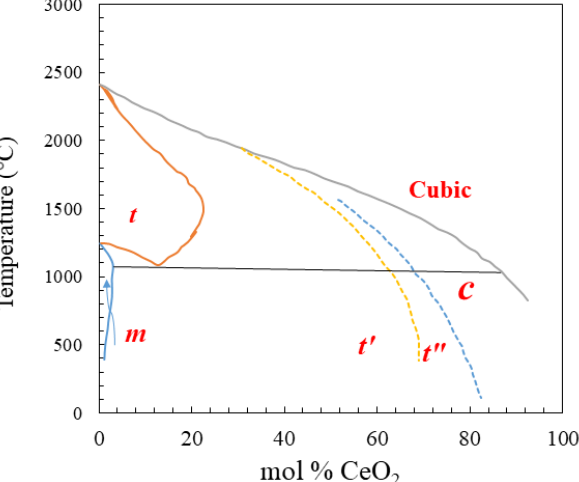
Figure 5. Phase diagram study of CeO 2 -ZrO 2 system with different CeO 2 concentrations as a function of temperature. t , t ’ , and t ” demonstrate the three forms of the tetragonal phases,m refers to the cubic phase, and m denotes the monoclinic phase [48].